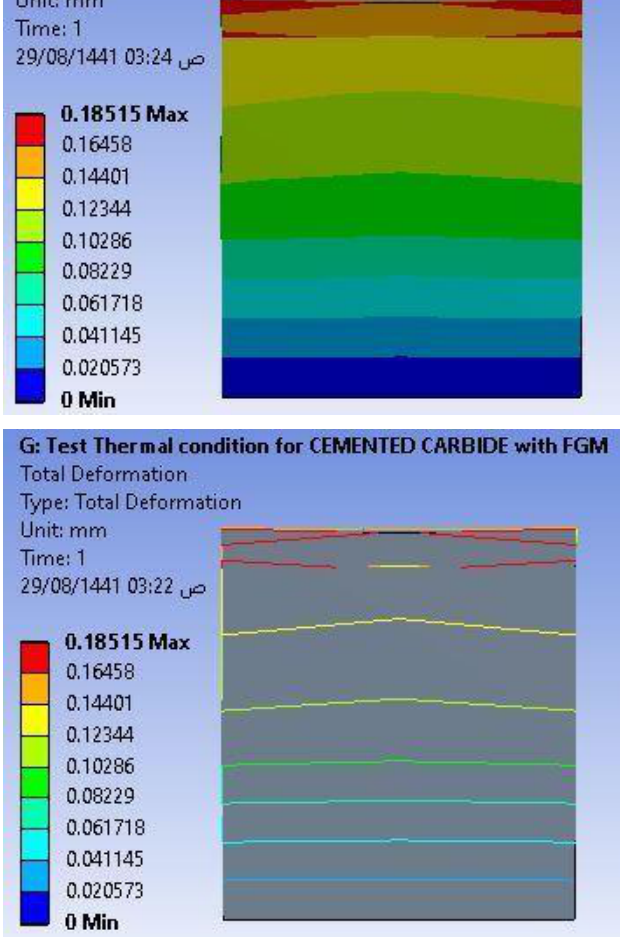
Fig. 18. Graph of total deformation Wireframe shape